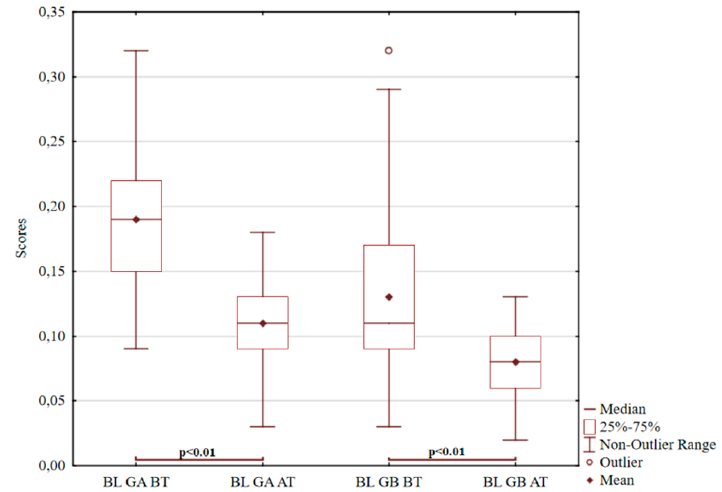
Figure 3. Graf 3 ROR for the interpretation of blood.